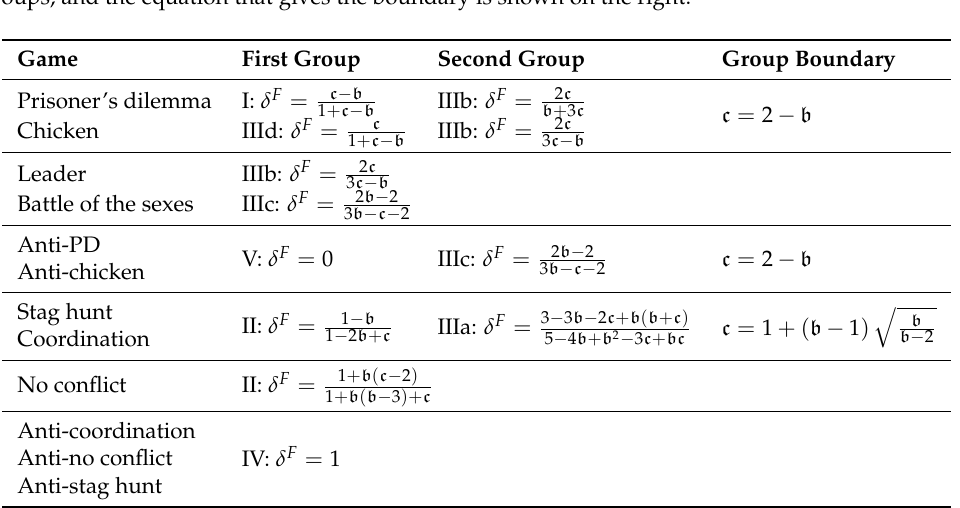
Table 1. The values of the discount factor δ F without public correlation. Some games have multiple groups, and the equation that gives the boundary is shown on the